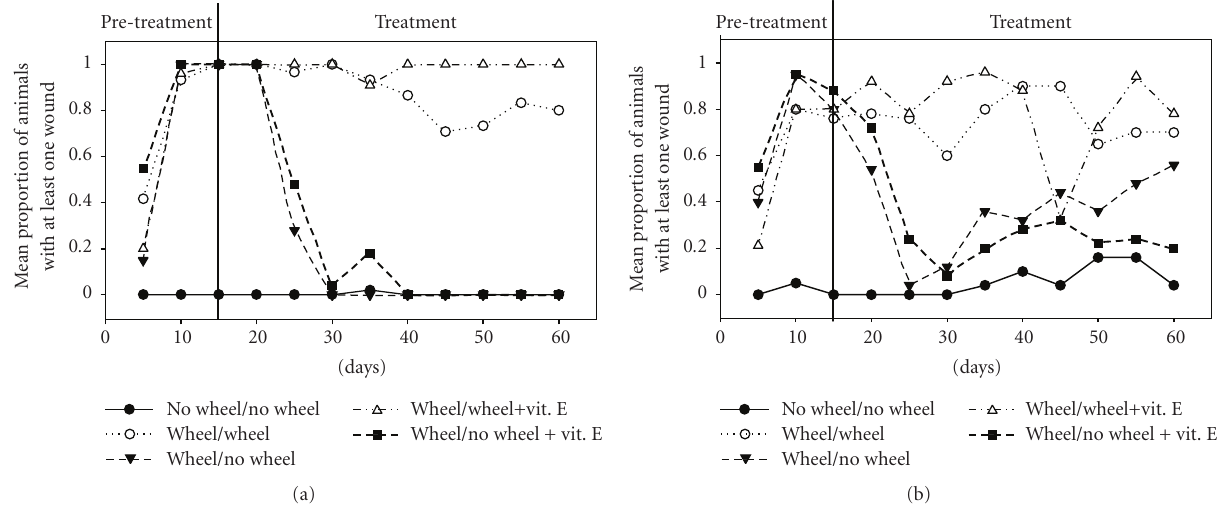
Figure 1: Proportion of male (a) and female (b) hamsters showing at least one paw wound during the experiment. Data points show the mean for the past five days and the five animals of each experimental groups, the names of which indicate their pretreatment and treatment conditions. “No wheel/No wheel” and “Wheel/Wheel” were the control